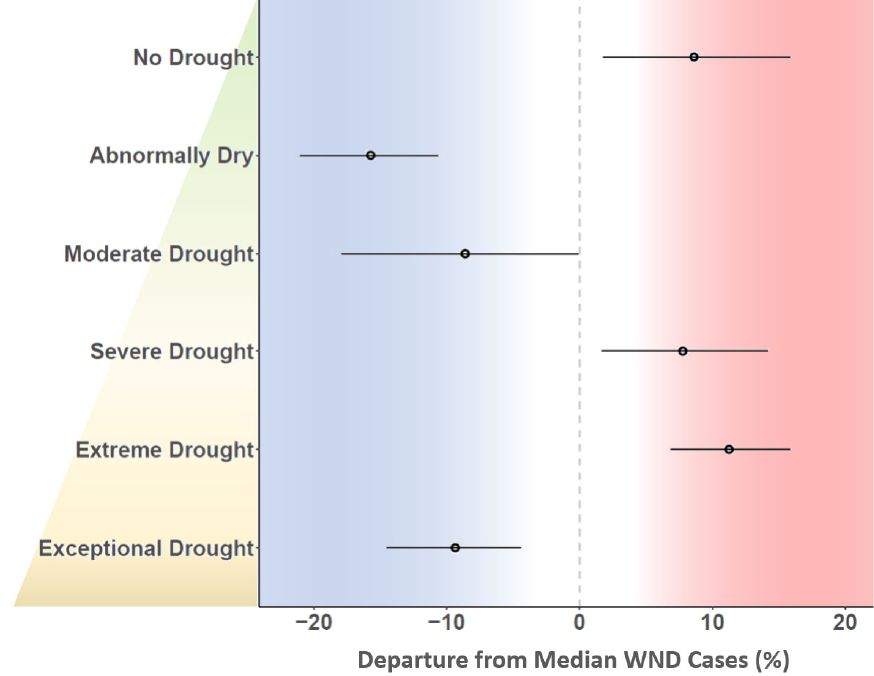
Figure 7. Relationship of drought to equine WND. Vertical axis at left lists US Drought Monitor categories arranged ( top to bottom ) from the least to most dry stage. Horizontal axis is scaled to show relative change (%) in equine WND cases with respect to the median case rate of 3.88 (1.83, 6.67 CI) cases/100,000 horses, which is represented by the dashed vertical line intersecting zero. Point symbols in main plot area represent the mean coefficient estimate for each drought category with a corresponding line defining the 95% CI.